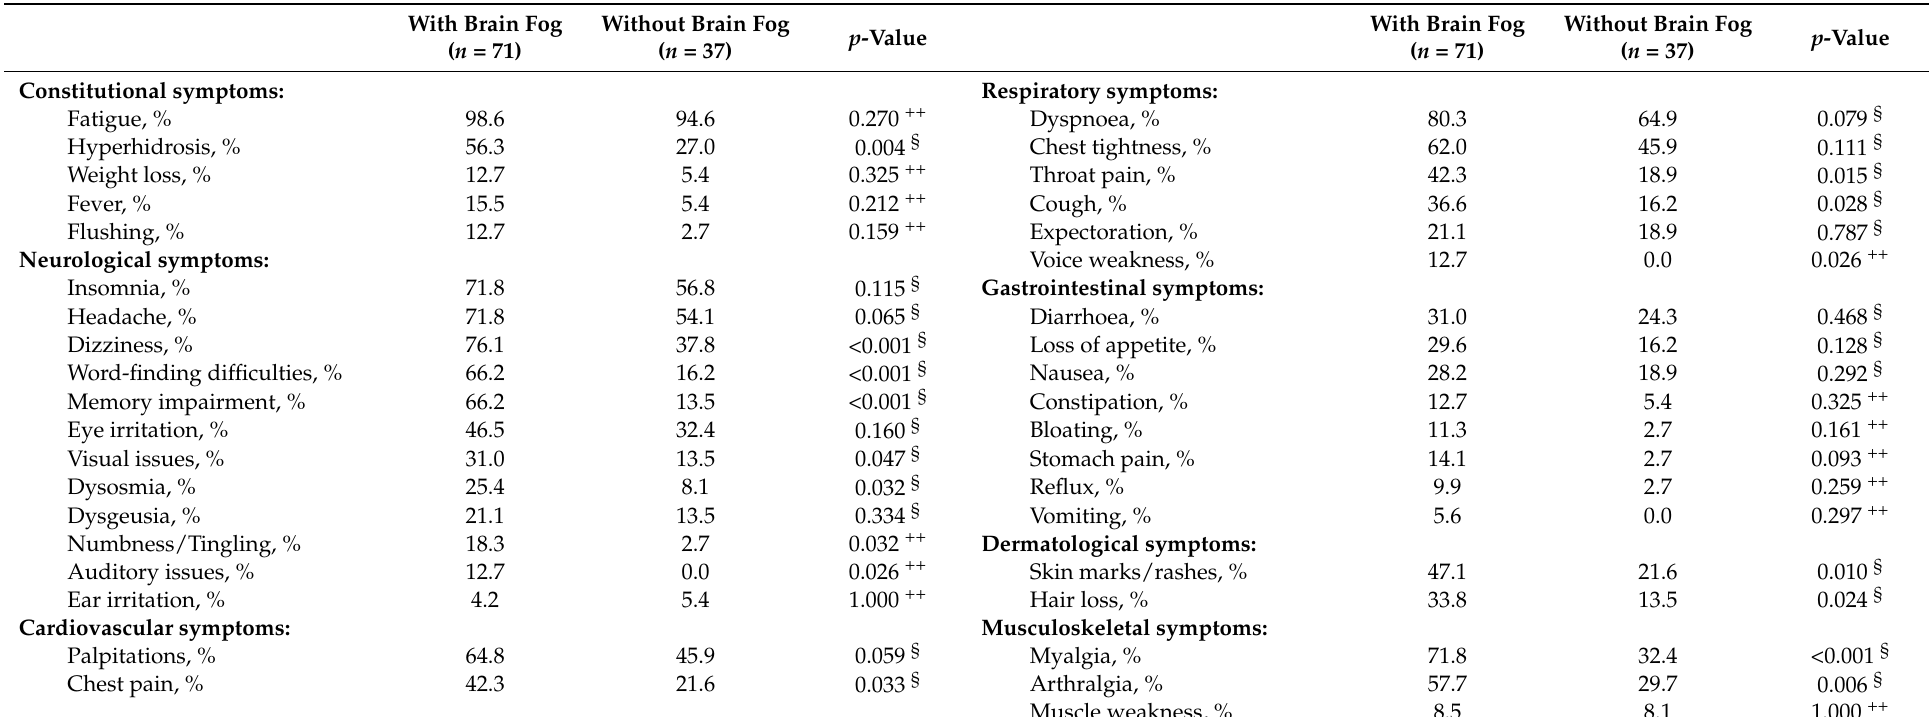
Table 2. Long COVID symptomatology comparison between participants with and without brain fog. With Brain Fog Without Brain